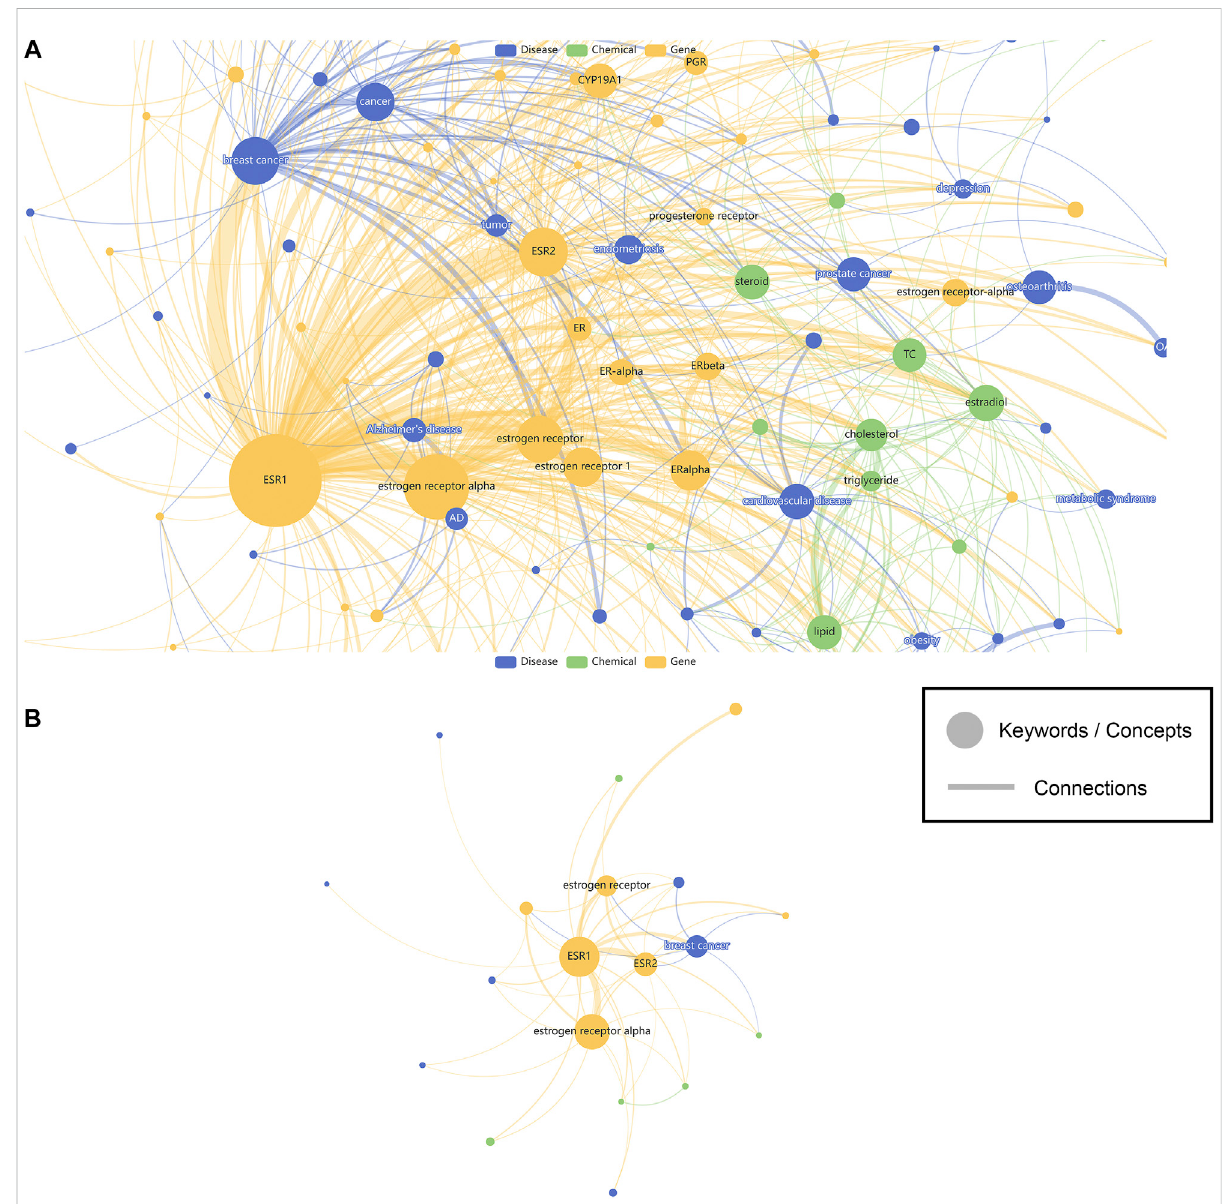
FIGURE 2 ThevisualizationofSNPassociatedkeywords. (A) Showallkeywords. (B)